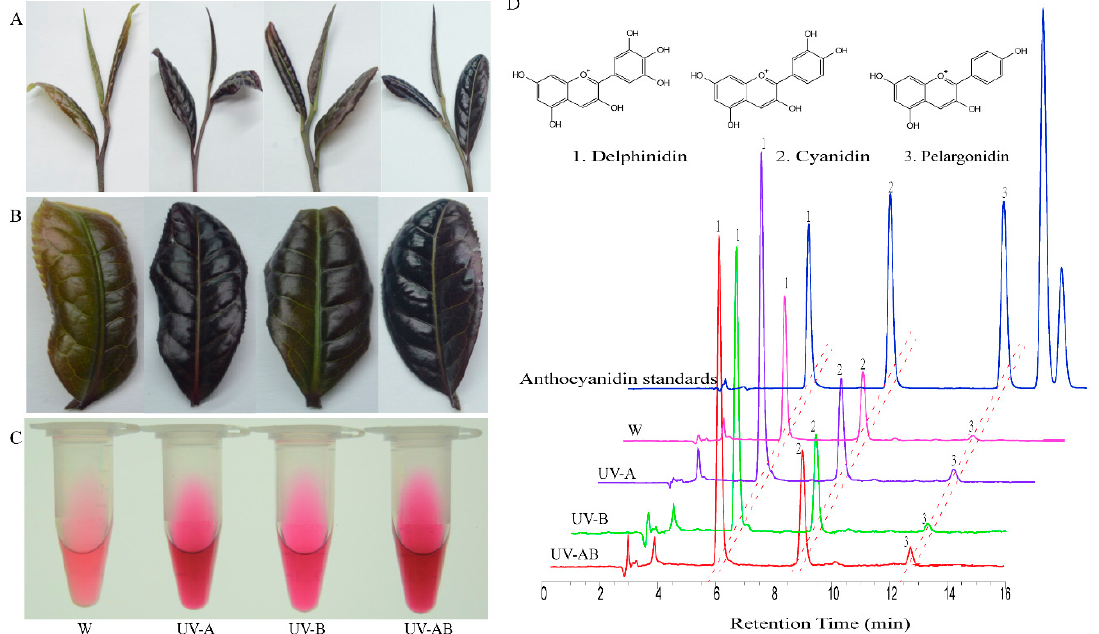
Figure 1. Phenotype of young shoots, anthocyanin extract and component analysis of anthocyanidins in di ff erent treatments. ( A – C ) represented one bud and two leaves (1B2L), the second top leaf of one bud and two leaves, and anthocyanin extract of one bud and two leaves in W, UV-A, UV-B and UV-AB treatment, respectively. ( D ) High-performance liquid chromatography (HPLC) chromatogram of the pigments extracted from one bud and two leaves in di ff erent treatments. W, UV-A, UV-B, and UV-AB represent under white light, ultraviolet-A, ultraviolet-B, and ultraviolet-(A + B) treatment, respectively.